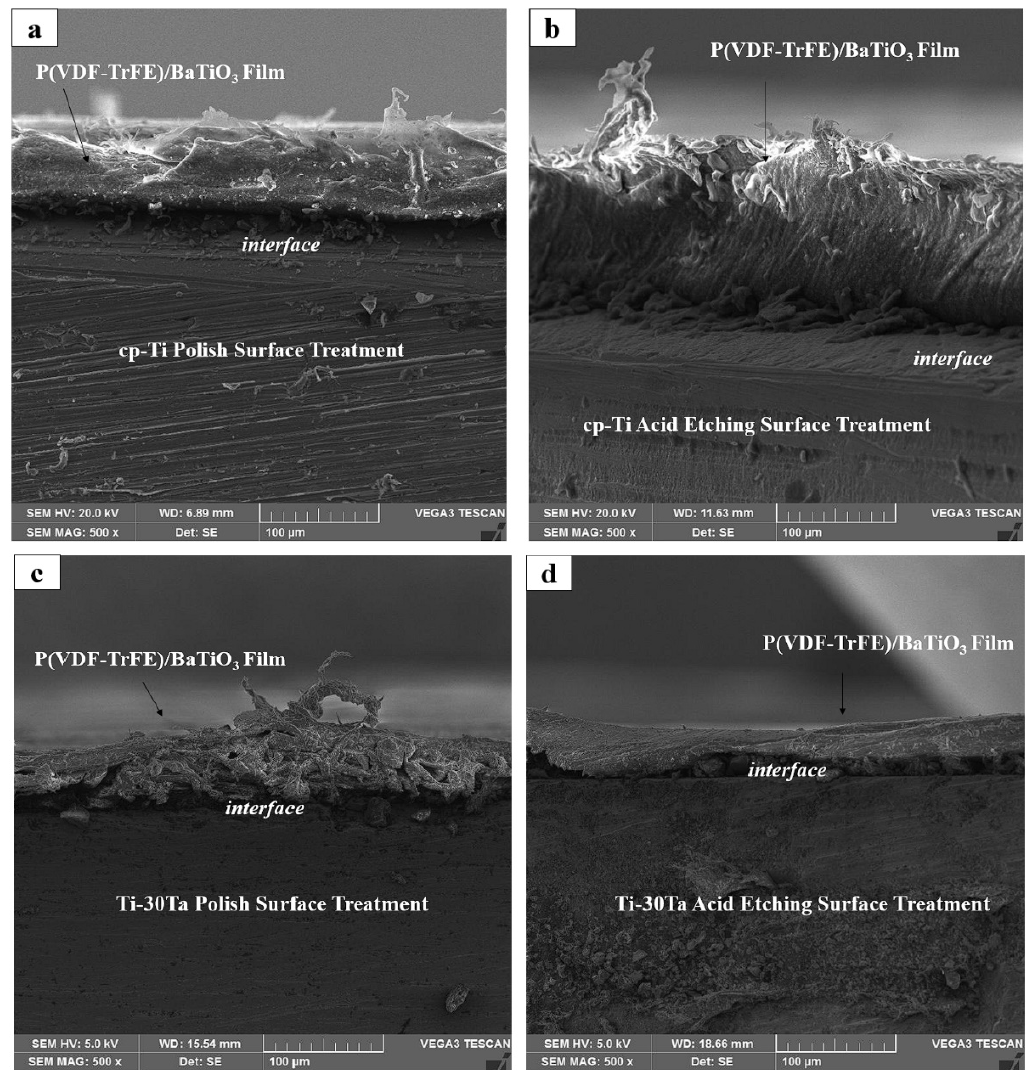
Figure 11. ( a , b ) cp-Ti substrate interface view, showing an adhesive failure; ( c , d ) Ti-30Ta substrate interface view.